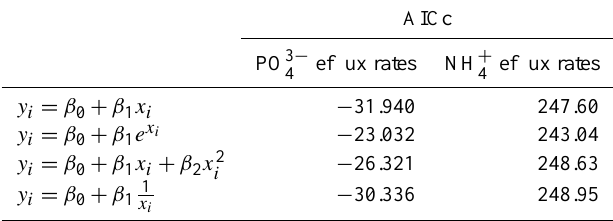
and NH + efflux 4 4